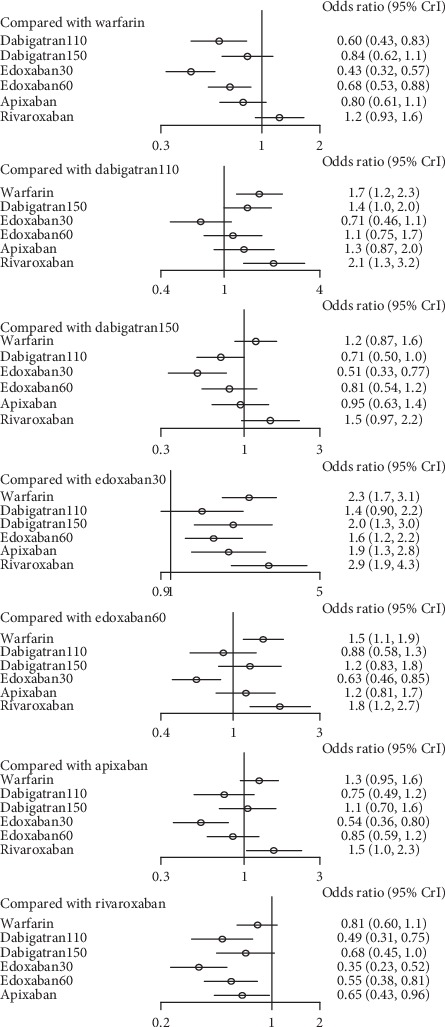
Forest plot for the safety of the comparison among different treatments of patients with normal renal function.